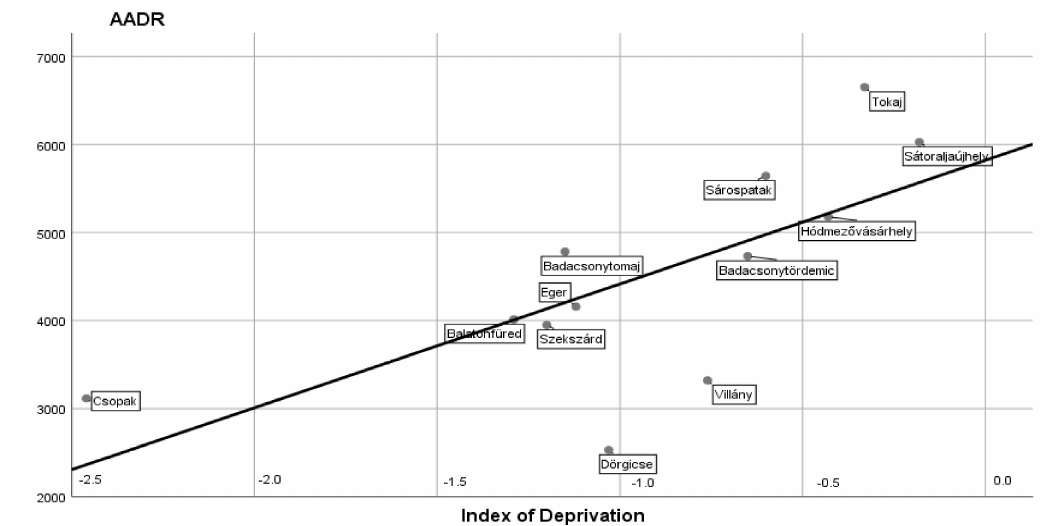
Figure 2. A positive correlation (r = 0, 690; p < 0.013) between the AADR values due cardiovascular diseases and indices of socio-economic deprivation found in 12 settlements of the five regions in a population larger than 200,000 persons.